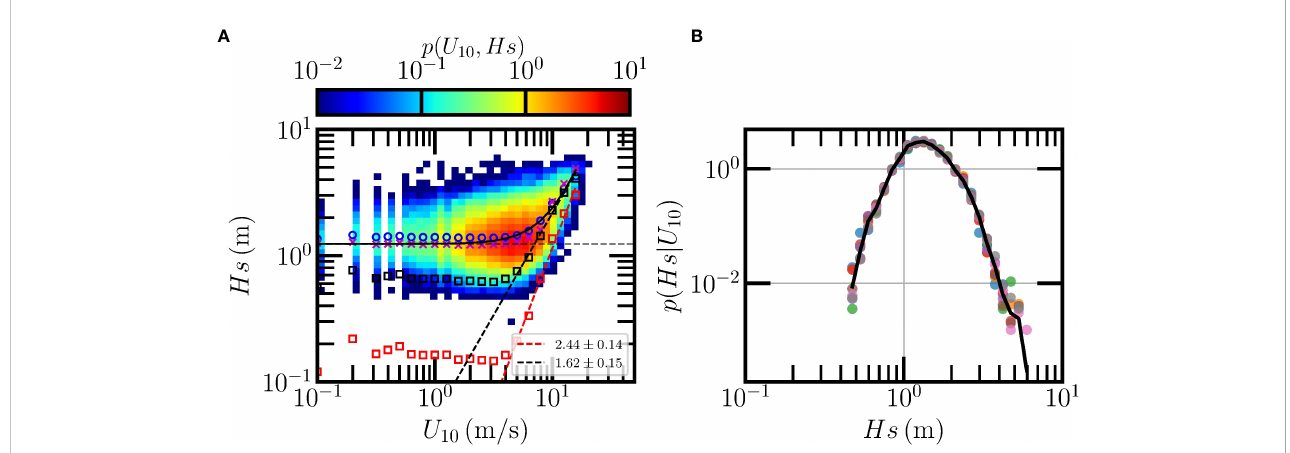
FIGURE 3 (A) Measured joint PDF of U 10 and Hs collected by NDBC buoy 46086, where the open circles (O) are the conditional mean (cid:1) Hs ( U 10 ); crosses (× ) are the skeleton Hs 0 ( U 10 ) of the joint PDF; the red squares and black squares are the local signi fi cant wave height (cid:1) Hs Ll ( U 10 ) and (cid:1) Hs Le ( U 10 ) derived via the linear decomposition and energy conservation approach, respectively. The dashed lines are the best fi ttings of the relation between (cid:1) Hs L ( U 10 ) and U 10 . The black solid curve is a reconstruction of the (cid:1) Hs ( U 10 ) based on Equation (16). (B) The conditional PDFs p ( Hs | U 10 ) for Hs at small wind speeds, e.g., U 10 ≲ 4 m/s. The solid curve is the average